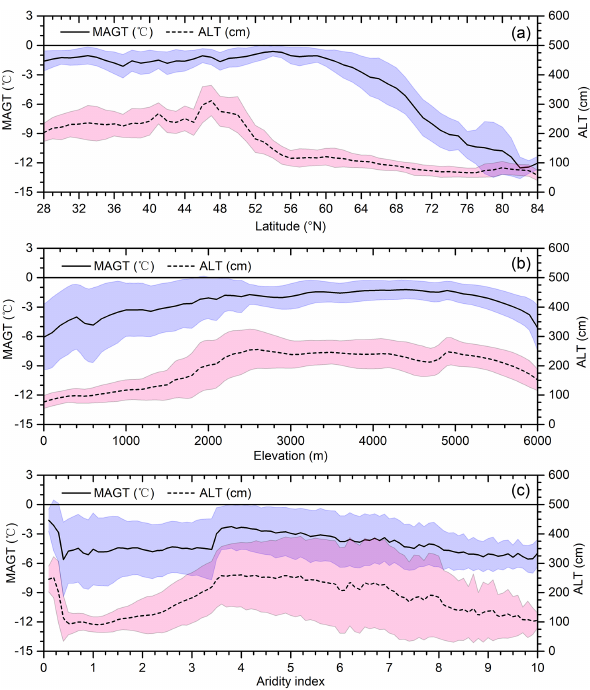
Figure 5. Mean annual ground temperature (MAGT) and active layer thickness (ALT) along latitude (a) , elevation (b) , and aridity index (P/PET) (c) transects in the Northern Hemisphere (the black solid line is mean MAGT, and the light blue shaded area is its stan- dard deviation; the dashed line is mean ALT, and the pink shaded area is its standard deviation; the dark pink area in panel c is the overlapped shaded area between ALT and